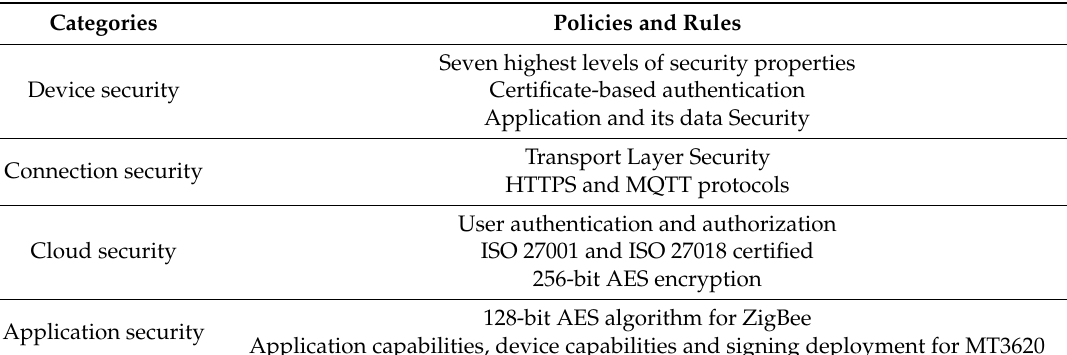
Table 2. Security considerations in this